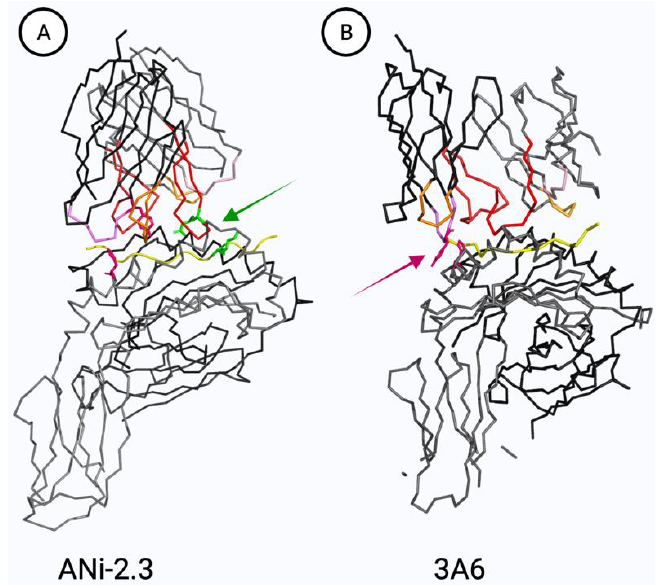
Figure 3. Structure of TCR-pMHC II complexes. TCR α - and β -chains (top) with CDR3 regions (CDR1, pink; CDR2, orange; CDR3, red) are positioned diagonally over MHC II α - and β -chains (bottom) and the presented peptide antigens (yellow). ( A ) Ni-specific TCR ANi-2.3 (TRAV8-TRBV19) in complex with a peptide mimotope (pdb ID code 4h1l). Lys 7 likely replaces Ni in this structure with Asp 95 being an essential contact point (green stick representation, [209]). ( B ) TCR 3 A6 (MBP 89-101-specific, TRAV9-2-TRBV5) represents the only available TCR-pMHC II structure of a human TRAV9-2 TCR (pdb ID code 1 zgl). His 81 is a major TCR contact point in the MHC II β -chain and is in close proximity with Tyr 36 in the TCR α -chain CDR1 of TRAV9-2 (pink stick representation). A recent study found that approximately 35% of Ni-specific TCR expressed TRAV9-2 compared to ~5% in the random repertoire [115]. The depicted TCR do not express a histidine in their CDR3 regions, which constitutes an independent recently discovered major Ni binding mechanism [115] (see Section 3.2). Created with Pymol.